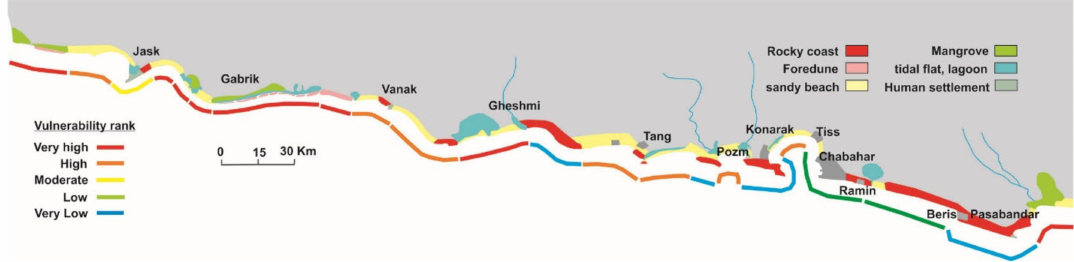
Figure 8. Risk rating of the Iranian coast of Makran based on geomorphology and environmental sensitivity.